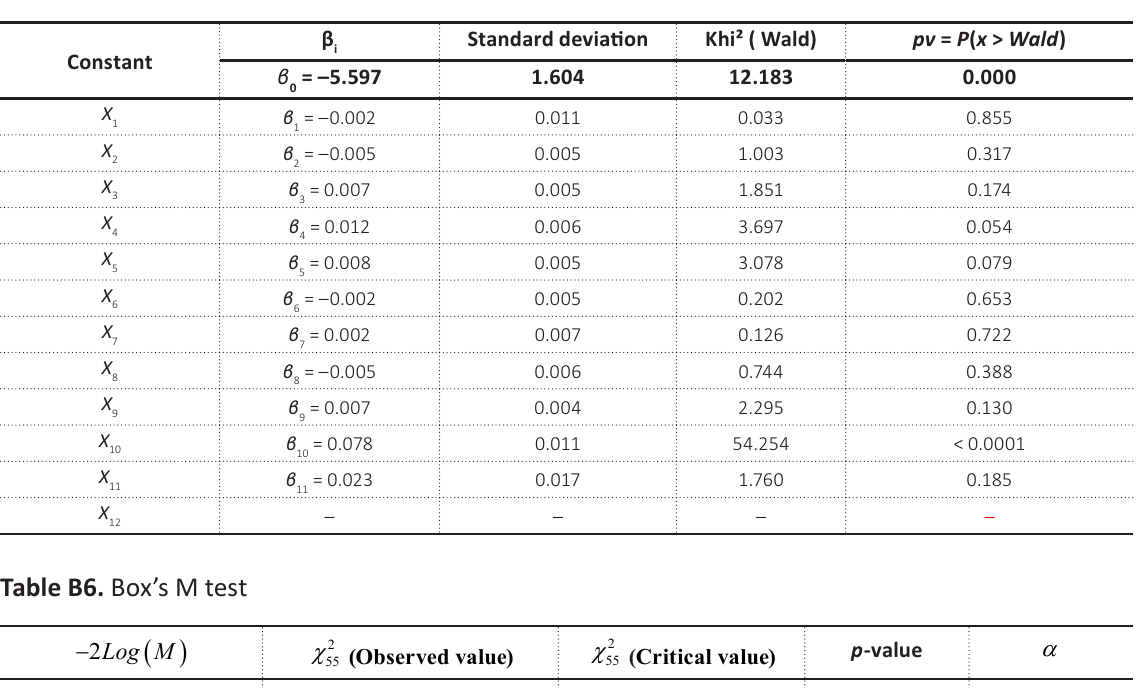
Table B5. Parameter estimation and Wald test